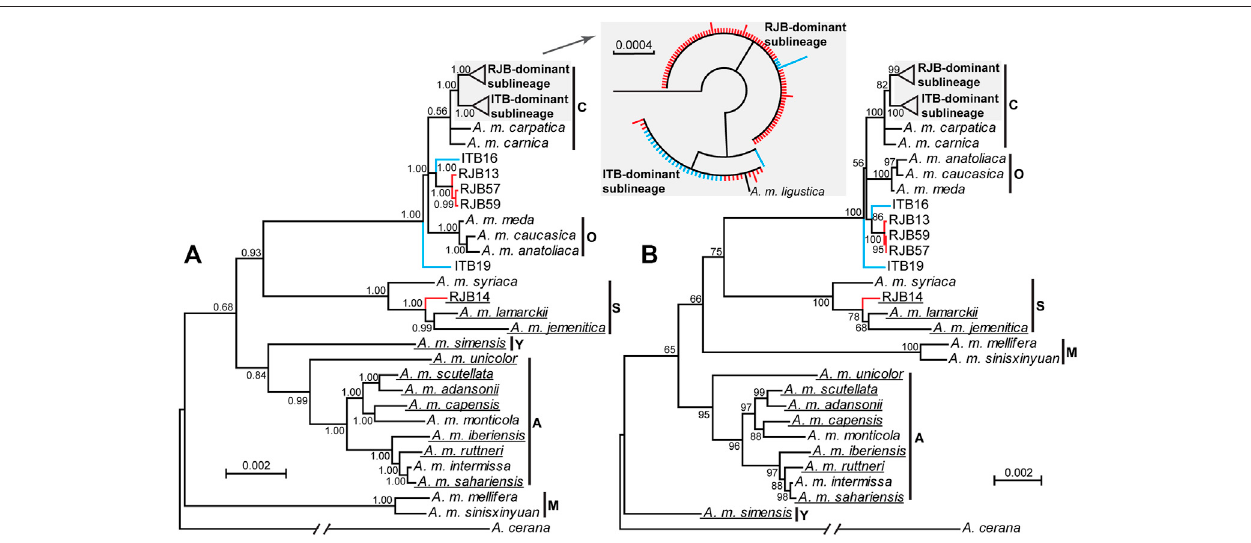
FIGURE 3 | The phylogenetic trees of A . mellifera subspecies. Posterior probabilities for the Bayesian inference tree (A) and bootstrap values for the maximum likelihood tree (B) are shown at nodes. The branch of the outgroup A . cerana is truncated. Subspecies with long insert in the intergenic spacer between cox2 and trnL2 are underlined. The previously designated six lineages (A, C, M, O, S, and Y) for A . mellifera are indicated. The clades for the RJB- and ITB-dominant sublineages are shaded. The clustering pattern of the two sublineages is similar in the two trees and is shown in the inset (red color for RJBs and blue for ITBs) for the Bayesian inference tree.